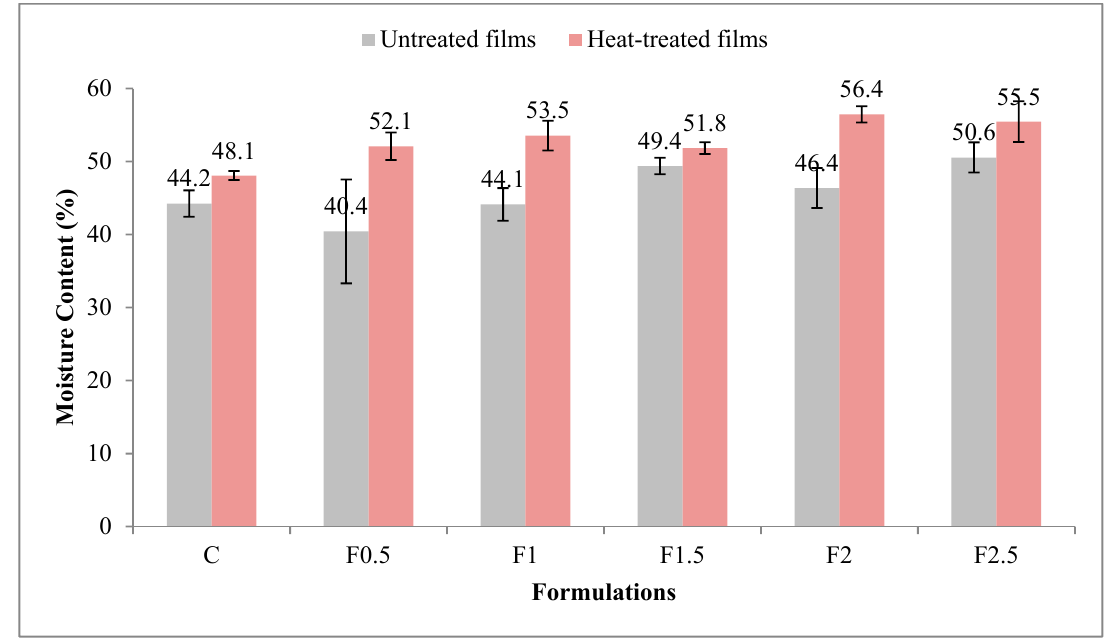
Figure 3. Variation in moisture content with heat treatment and formulation. C-control film; F0.5-film with 0.5% tarragon essential oil; F1-film with 1% tarragon essential oil; F1.5-film with 1.5% tarragon essential oil; F2-film with 2% tarragon essential oil; F2.5-film with 2.5% tarragon essential oil. Values are expressed as mean ± standard deviation of four replicates. Polymers 2020 , 12 , x FOR PEER REVIEW